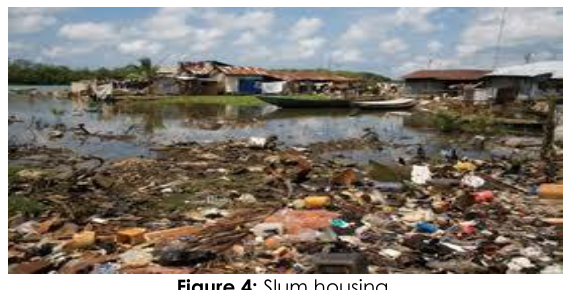
Figure 4: Slum housing.